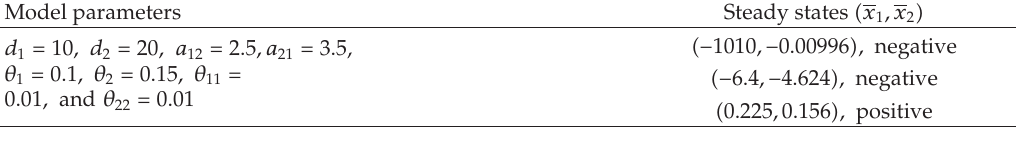
Model parameters